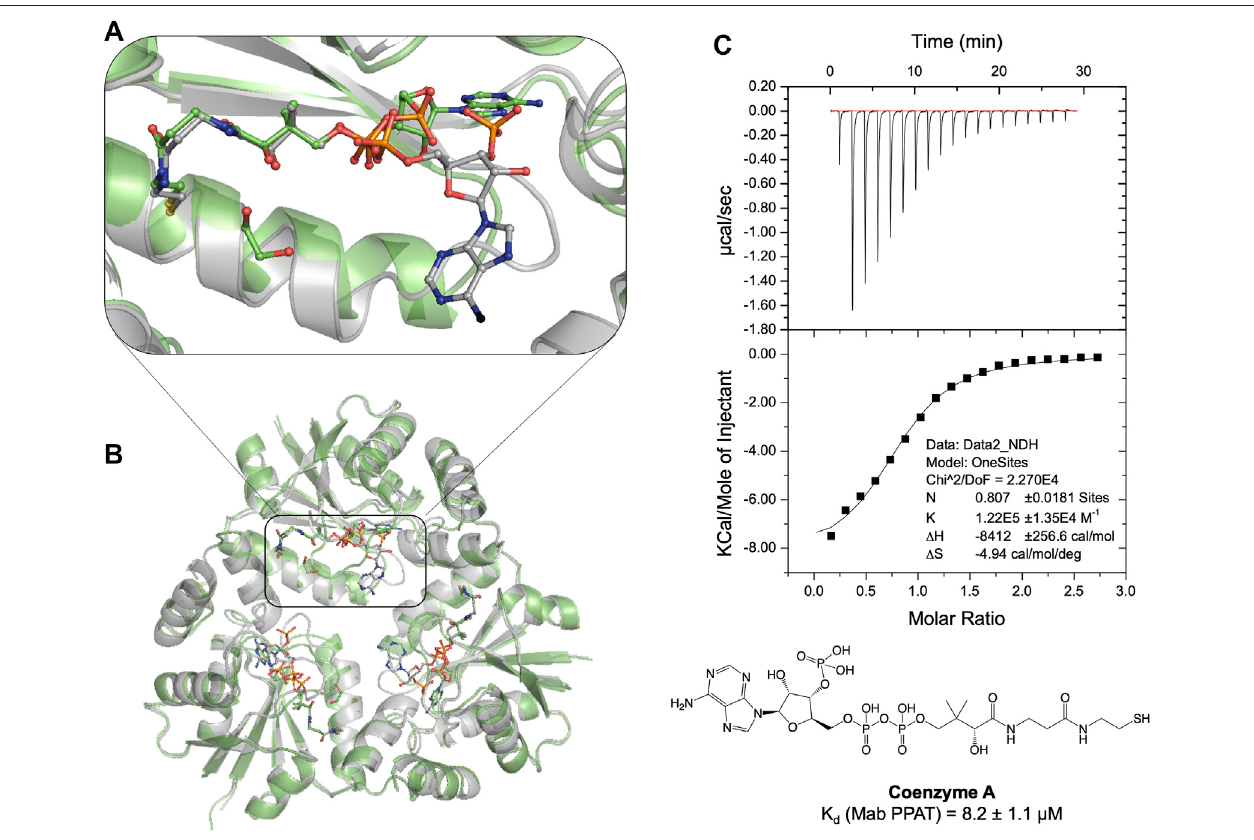
FIGURE2|(A) Structuralsuperpositionofapo Mab PPATincomplexwithfeed-backinhibitorCoA (grey), PDBcode7YXZ andproductdpCoA(green), PDBcode 5O08, showing conformational differences in the enzyme and ligand binding mode. (B) The pantetheine moiety of CoA adopts a similar conformation to that of dpCoA. However, the CoA adenosine moiety is seen very fl exible and largely solvent exposed in comparison to dpCoA in the Mab PPAT active site. (C) Thermodynamic (ITC) pro fi le of CoA interaction with Mab